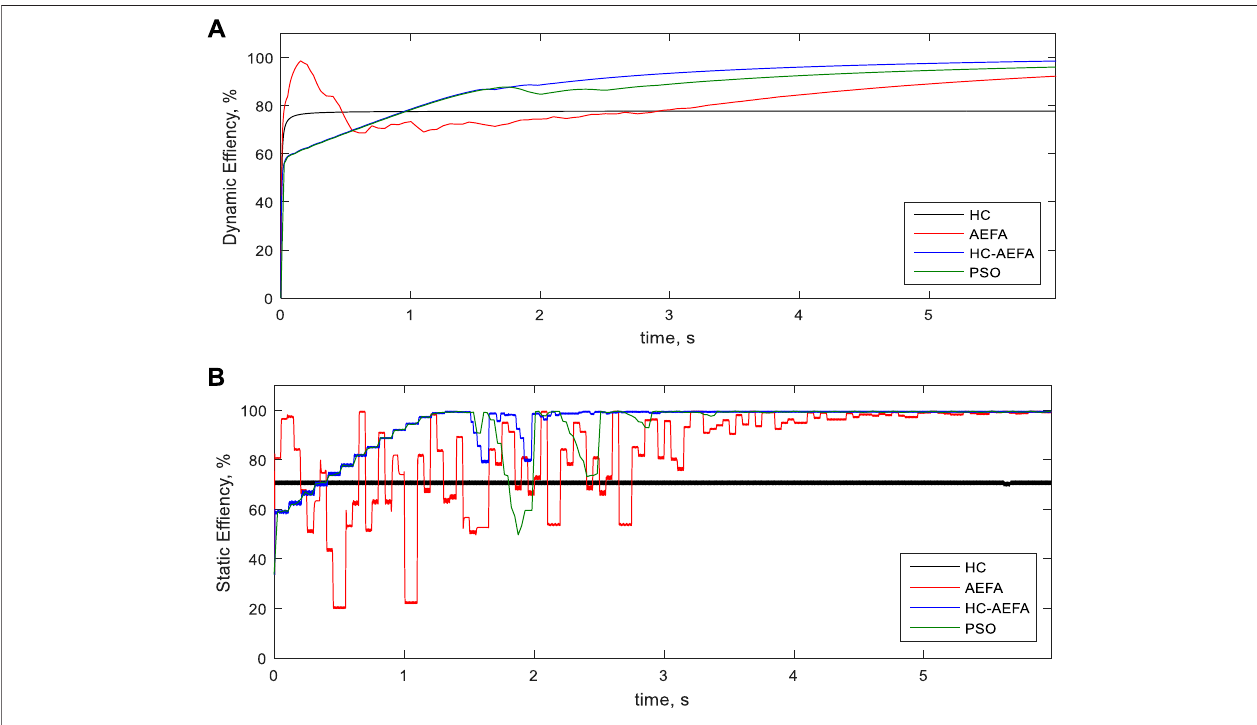
FIGURE 11 | Ef fi ciency curves at the third pattern obtained using the HC-AEFA, HC, AEFA, and PSO methods; (A) Dynamic- ef fi ciency, and (B) Static-ef fi ciency.